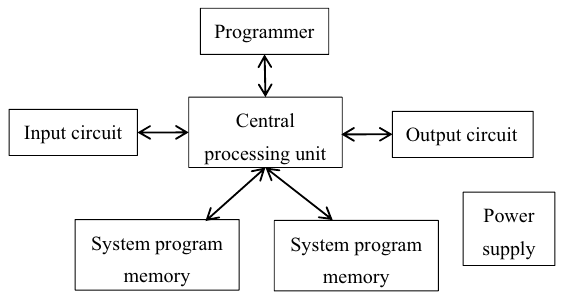
Figure 1: Basic structure of PLC system.